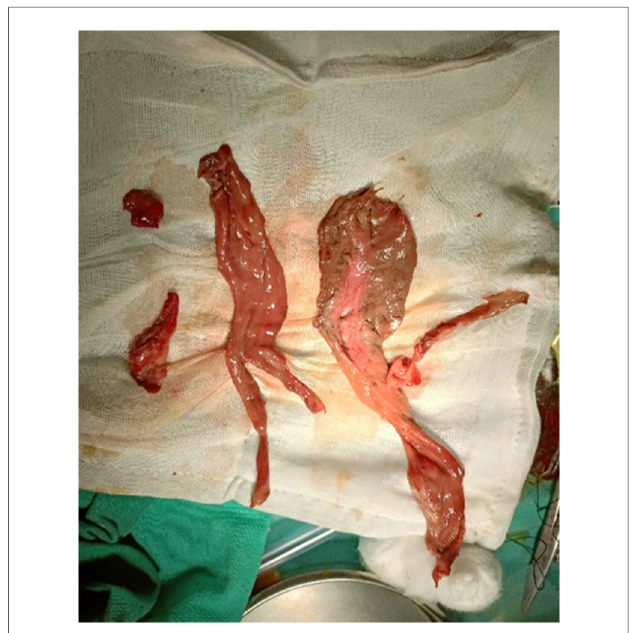
FIGURE 4 Complete excision of the vegetation was removed as far as possible and divided into several pieces of irregular tissue during the